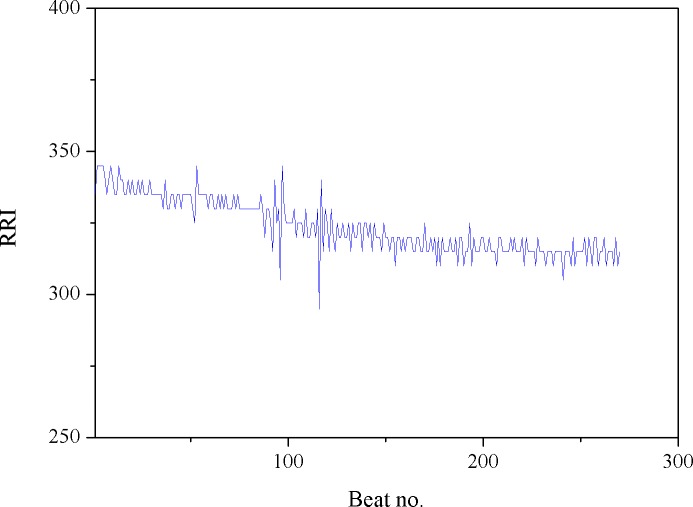
An RR data segment.